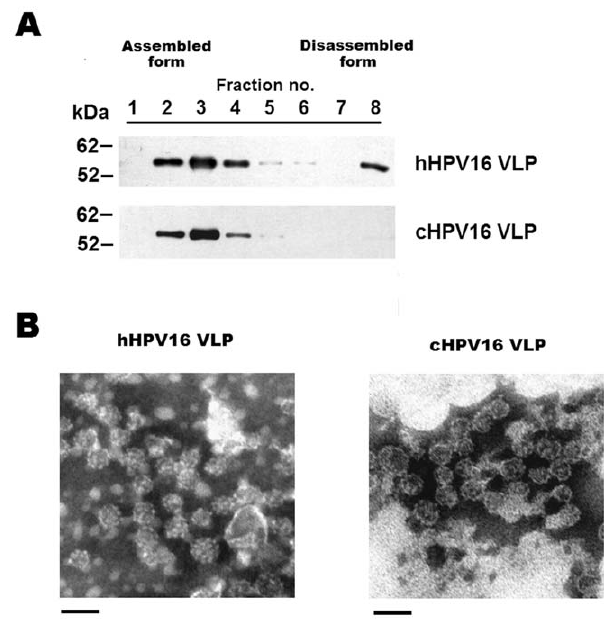
Figure 3. Analysis of the structural characteristics of hHPV16 and cHPV16 VLP. To analyze the structural integrity of the two VLP types, the HPV16 VLPs were fractionated on Optiprep density gradients (A). Eight fractions were collected in experiment A (0.5 ml each). The results of TEM analysis are presented in panel B. Magnification is 41,000 6 (bars 50 nm).